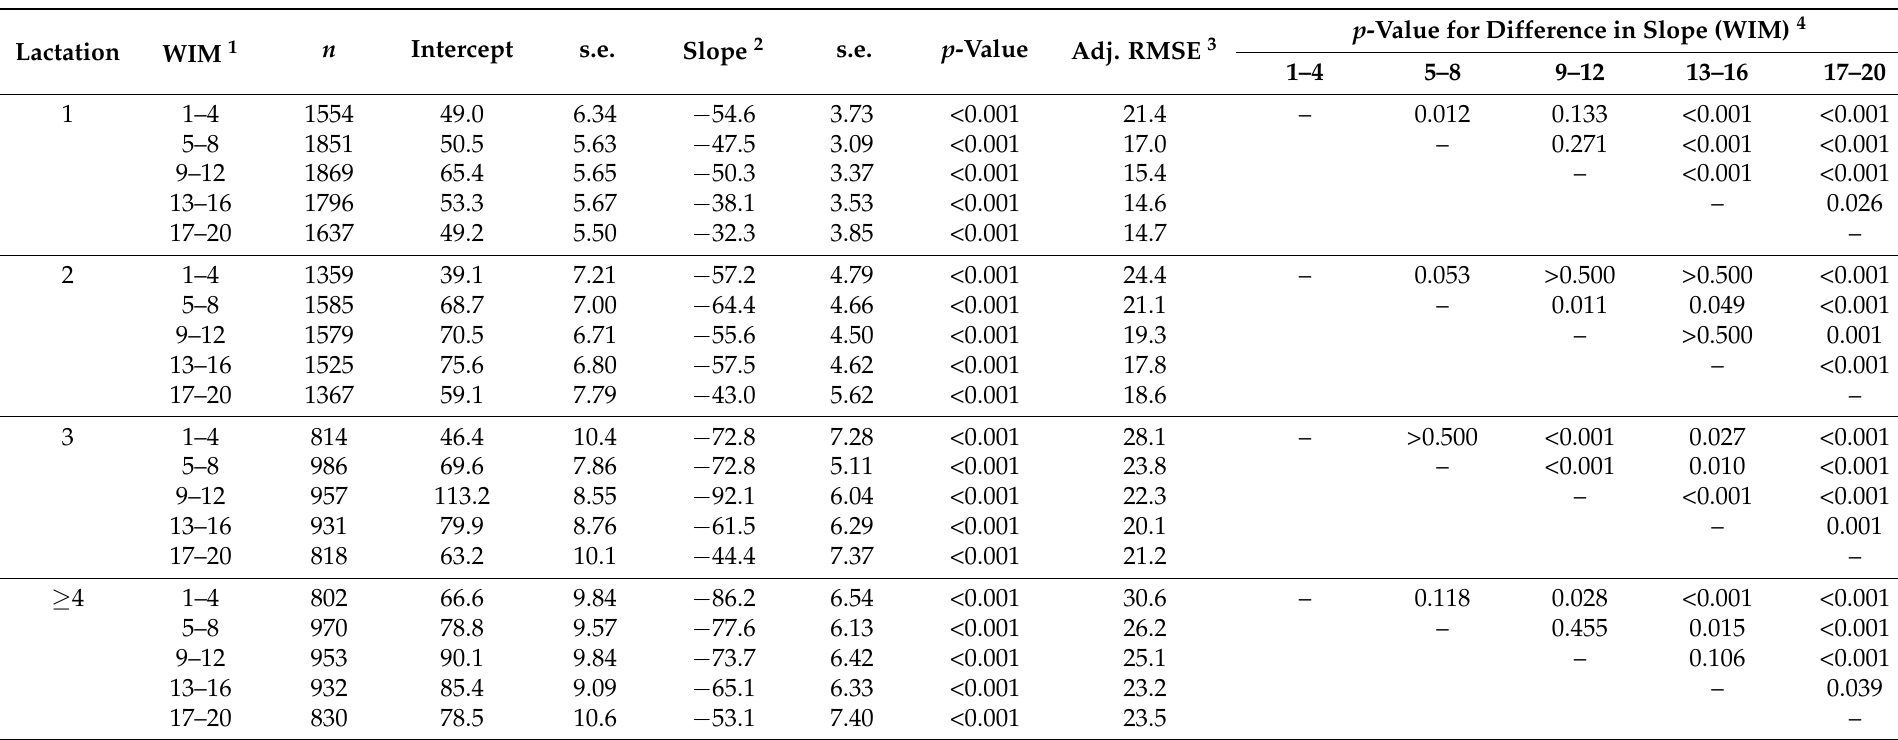
Table 3. Linear mixed regression models between fat-to-protein ratio in milk (FPR) and daily energy balance (EB, MJ of ME/day) in Holstein-Friesian dairy cows during early lactation (1–20 WIM), and comparisons of regression slopes between WIM intervals within each